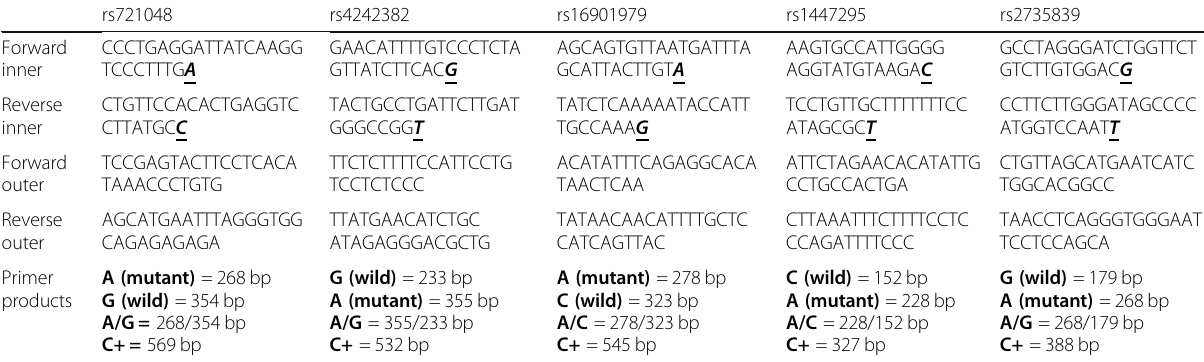
Table 1 Primer sequences and primer products